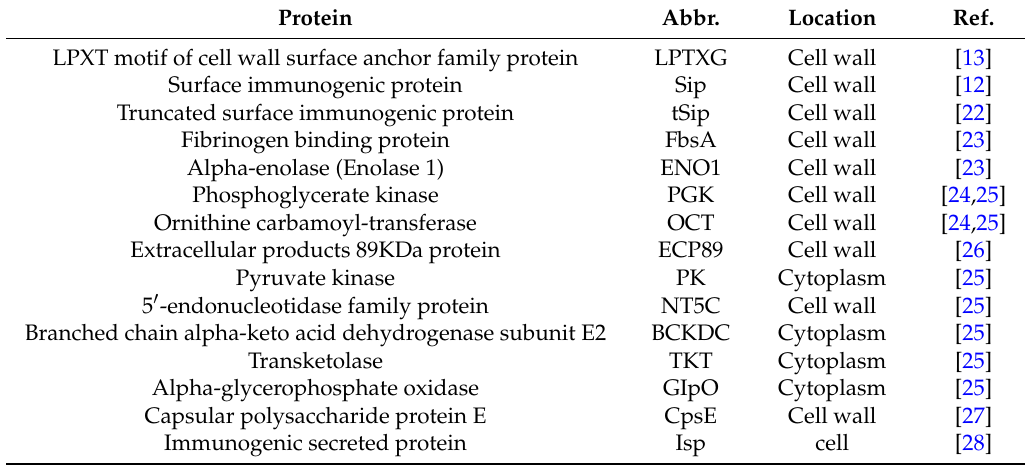
Table 3. Streptococcus agalactiae immunogenic proteins in tilapia ( Oreochromis niloticus ). Protein Abbr. Location